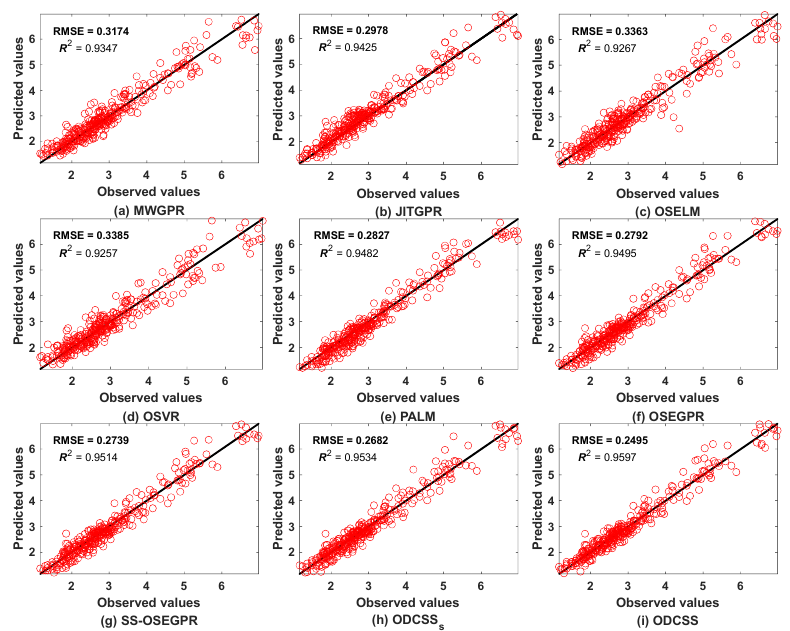
Figure 8. Scatter plots of substrate concentration predictions by different soft sensor methods.